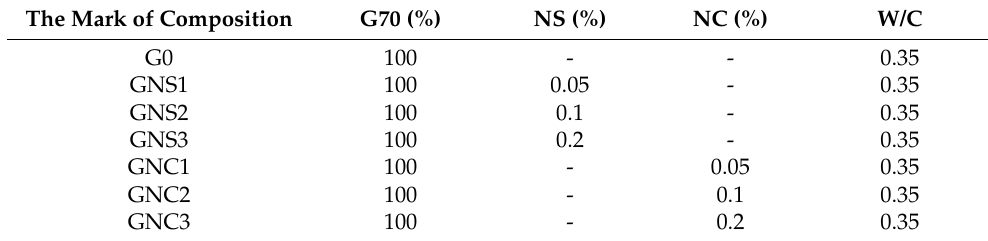
Table 2. Compositions (mass %) of the samples